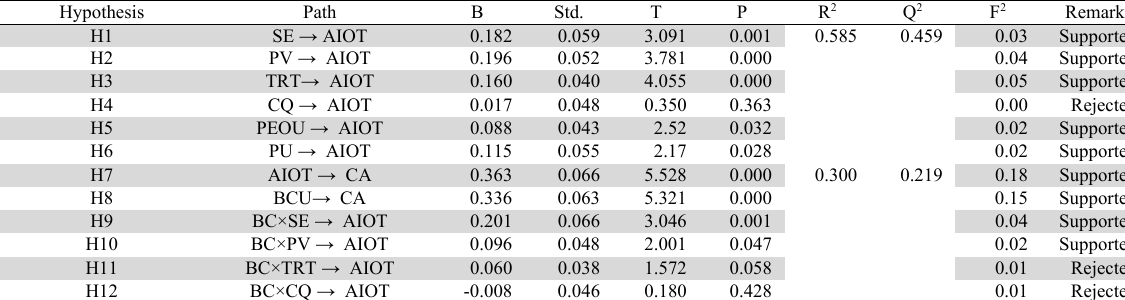
Results of Hypotheses Testing, R-square, Q-square, and F-square